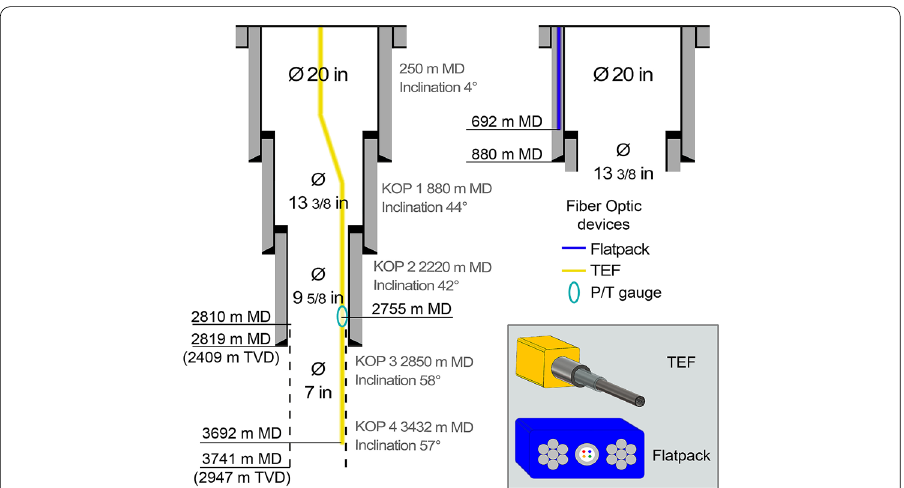
Fig. 1 Completion of production well 1 (left) and injection well 2 (right) with equipped fiber optic cables in Munich with relevant depths and kick-off points (KOP). Blue: with bumper wires equipped flatpack cemented (gray) behind the casing in injector well. Yellow: tubular encased fiber (TEF) installed along sucker rods to TD in producer well. Turquoise: fiber optic P / T gauge. Sketches of TEF and Flatpack are shown in gray